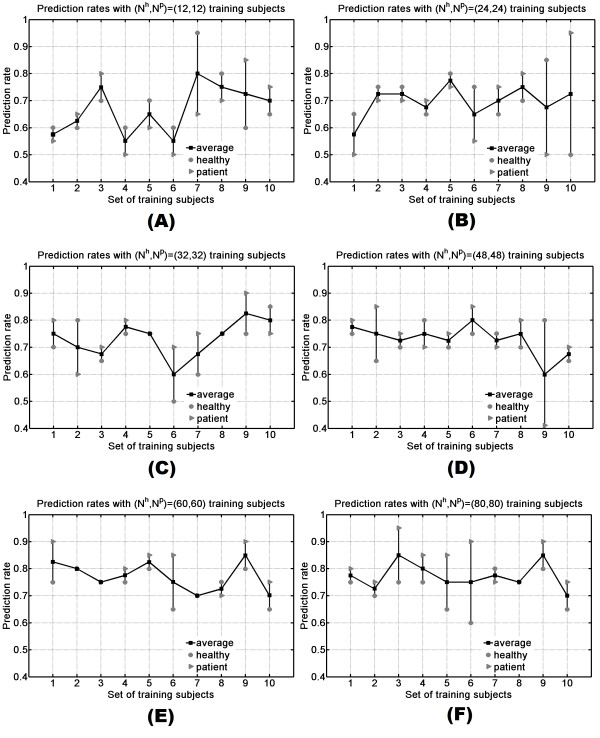
Comparison of prediction rates for each set of training subjects. Panels A to F show the average prediction performance of ten runs for each set Nlh,Nlp,l=1,6¯, respectively.